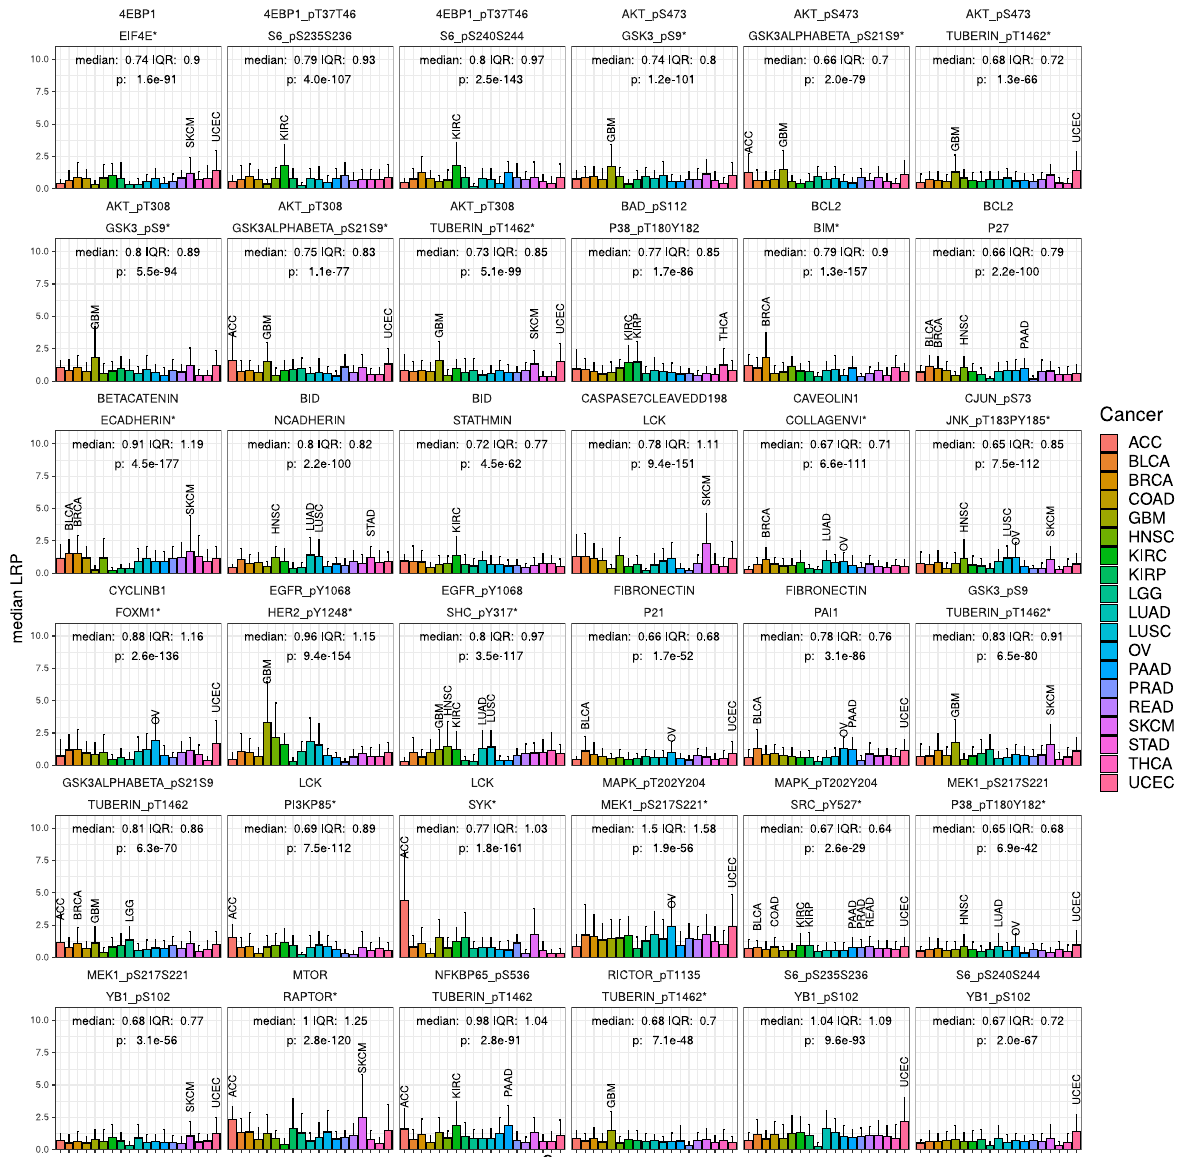
Fig. 1 Protein interactions with top LRP scores in the TCPA data set. Each subplot shows the median LRP au score (IQR indicated by error bars), grouped by tumor type, as a measure of the interaction strength for each pair of proteins given in the headings. In addition, the interquartile range (IQR) and the result of the Kruskal – Wallis test are reported. Several interactions our approach identi fi es are well known and belong to the mTOR pathway or regulate the cell cycle or apoptosis. Some interactions are highly differential between cancer types, e.g., EGFR and HER2, have particularly strong inferred interactions in glioblastoma, head and neck squamous cell carcinomas, and lung cancer and the strongest interactions between Cyclin B1 and FOXM1 are predicted for endometrial carcinoma and ovarian cancer. The reported in fl uence on phosphorylation of BAD at site S112 by P38-MAPK and Tuberin at site T1462 by AKT is re fl ected in high LRP au scores. Interactions marked with “ * ” have been reported in the Reactome database. More predicted interactions can be found in the Supplementary